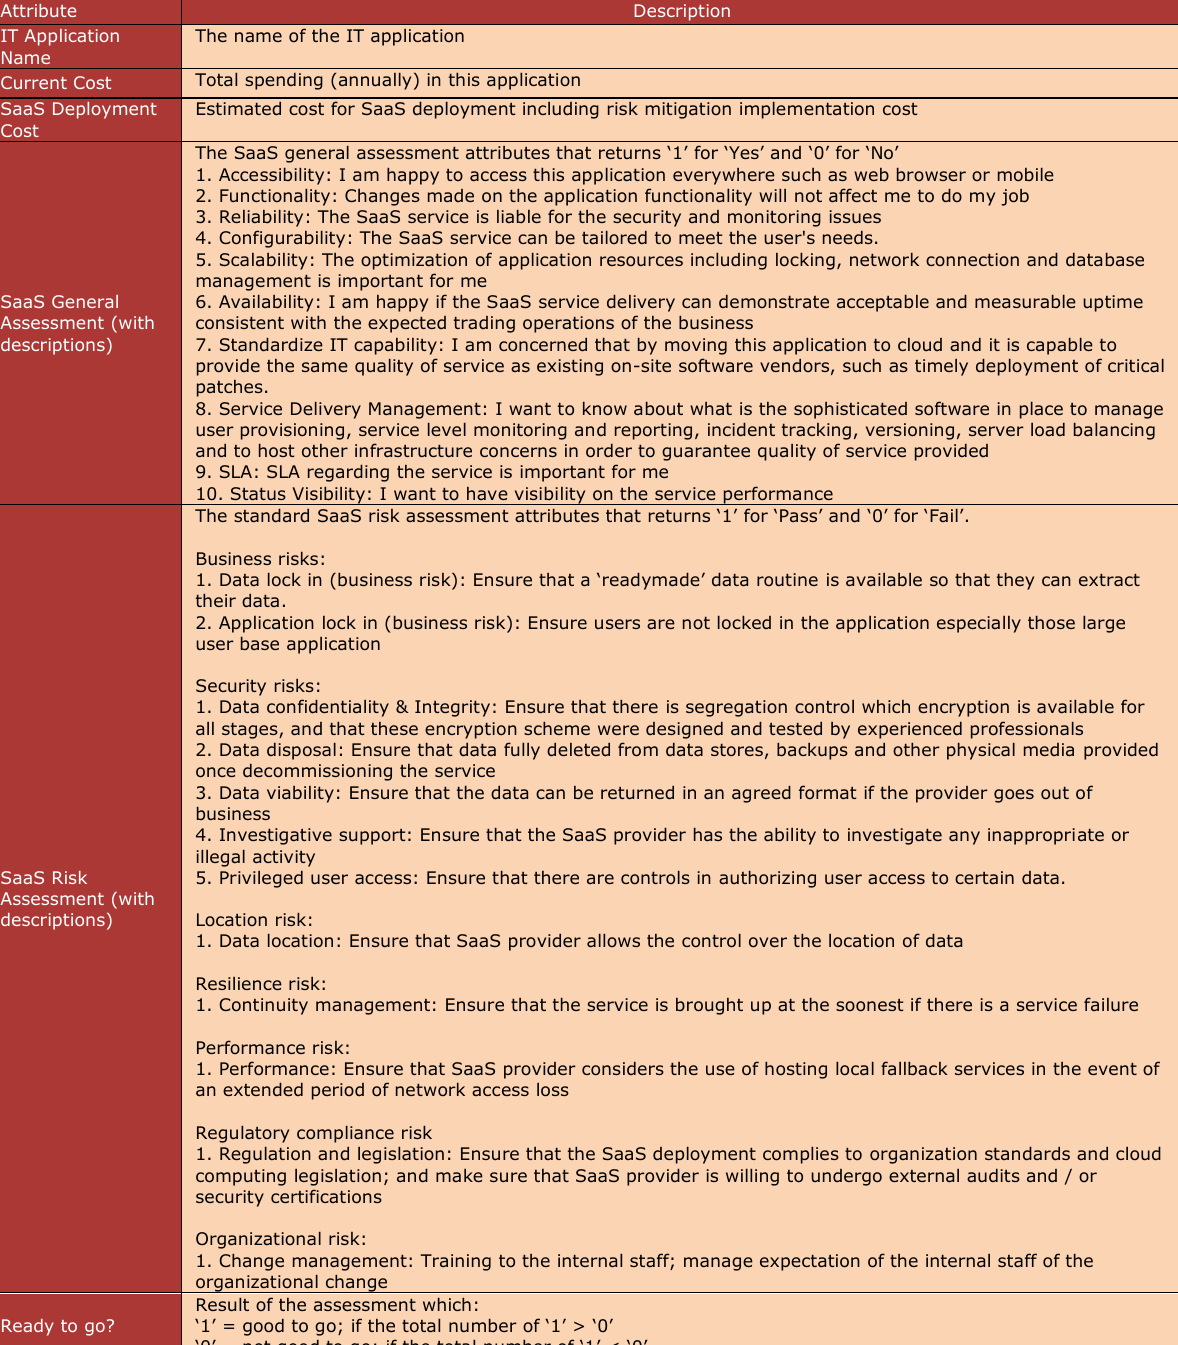
Table 5. SaaS Assessment attribute’s